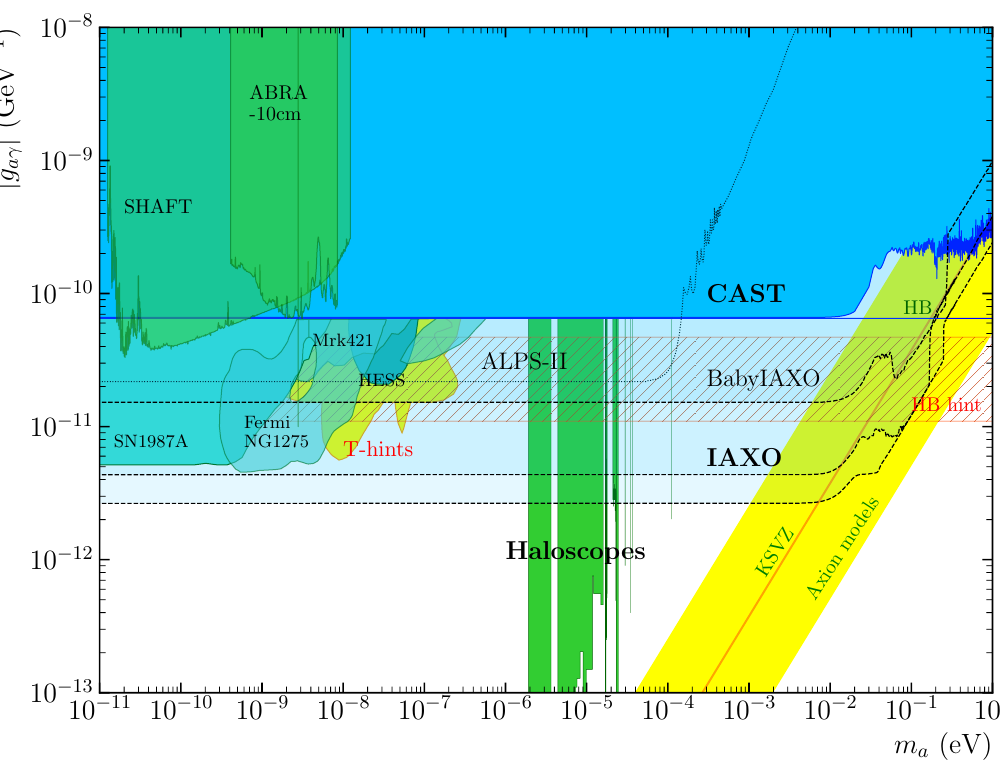
Figure 7: Excluded regions and sensitivity prospects in the ( g , m ) plane, with a a γ a focus in the g range relevant for helioscopes. Most relevant is the area excluded a γ by CAST, as well as prospects from future helioscopes like BabyIAXO and IAXO (for the latter two scenarios, nominal and enhanced, or IAXO + , are considered), and the LSW experiment (dashed and dotted lines). The “transparency hint” regions commented in section 4.2 are the yellow regions at low masses labelled as “T-hint”. The horizontal branch (HB) hint explained in section 4.1.1 is indicated as the red- dashed band labelled “HB hint”. All other green and blue regions are exclusions from the different experiments and considerations explained in the